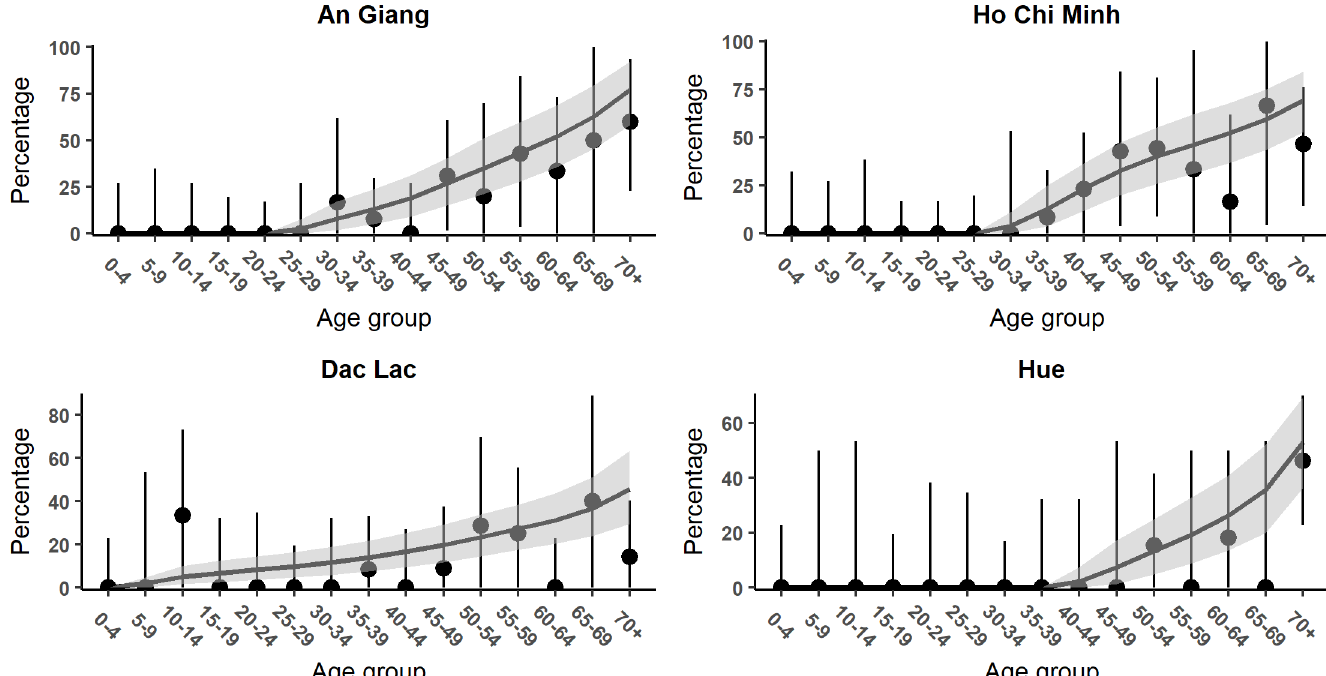
Fig 6. Model fit of the best fitting model to the age-specific seropositive proportion in each location. The black dots are the seropositive proportion in each age group along with corresponding binomial 95% confidence intervals, corrected by reported 90% sensitivity and 90% specificity of the test [69]. The black lines are the model output generated from the model simulated with the mean parameters estimates. The grey areas represent the 95% credible